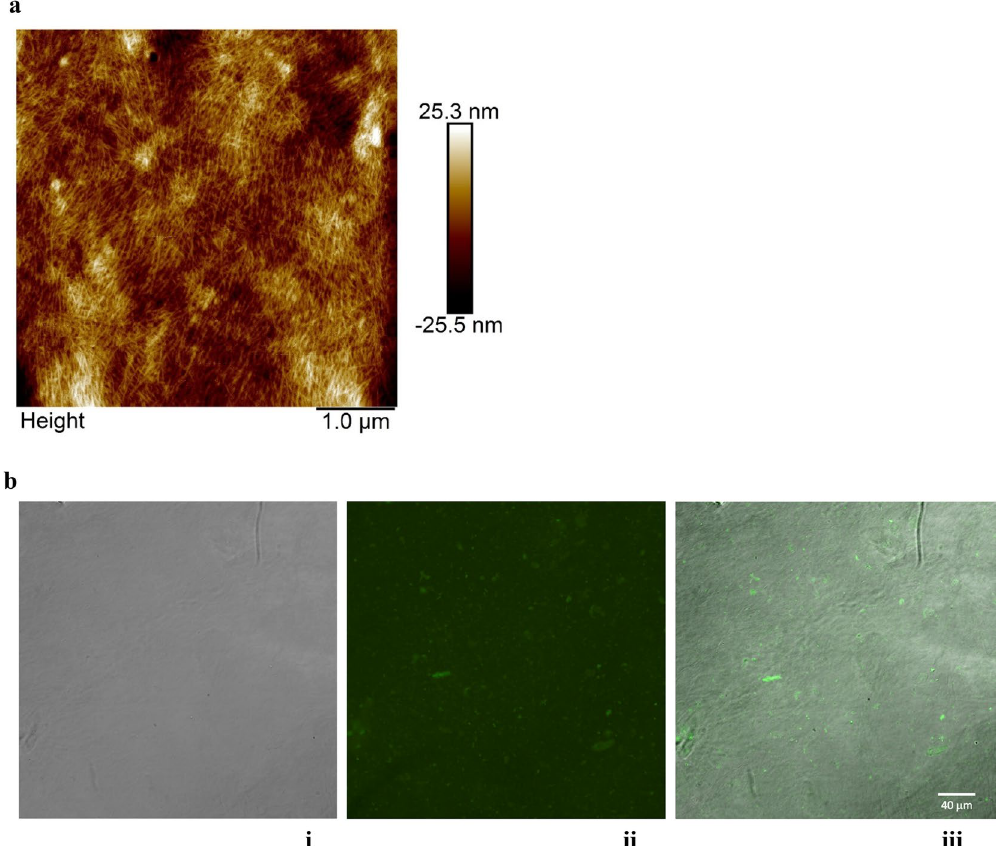
Figure 2. AFM and fluorescence images showed encapsulation of S protein Atomic force microscopy image of encapsulated clumps of S protein via crosslinking of ENC. S protein was irreversibly encapsulated in endospermic nanocellulose (ENC) matrix due to crosslinking. Thin nanoparticles of 1–5 nm are seen in a crosslinked scaffold; ( b ) Fluorescent S protein encapsulated in an ENC dried gel by differential interference contrast (DIC) imaging with fluorescent (488 nm excitation) confocal microscopy: ( i ) DIC image of the ENC membrane; ( ii ) fluorescent confocal image of entrapped Alexa Fluor 488 S protein clumps and ( iii ) overlay of ENC membrane showing the fluorescent clumps of S